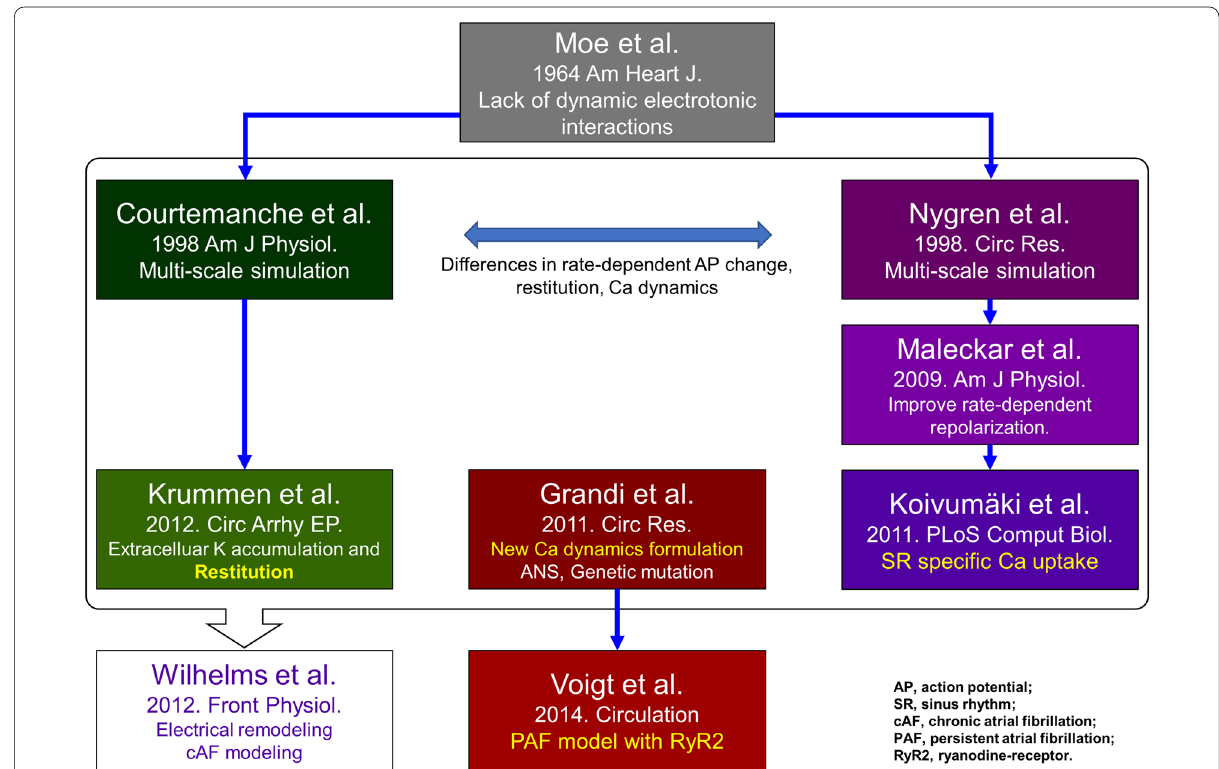
Fig. 1 Advances in various computational models for elaborate human atrial cellular